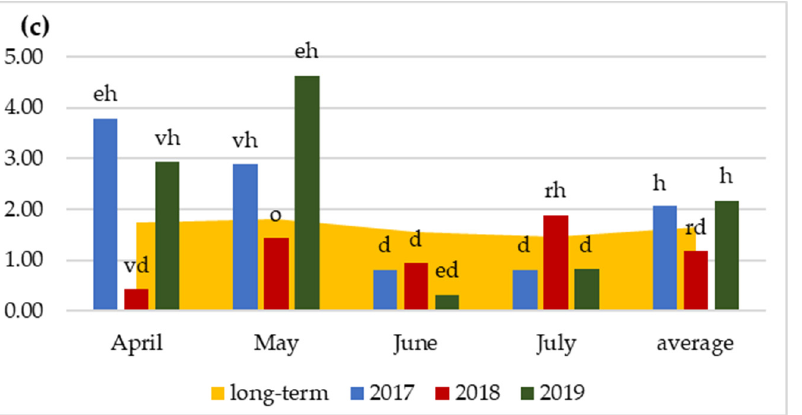
Figure 1. ( a – c ) Meteorological conditions during the wheat growing seasons. ( a ) precipitation (mm), ( b ) temperature (°C), ( c ) Sielianinov hydrothermal coefficient [18] (ed—extremely dry, vd—very dry, d—dry,